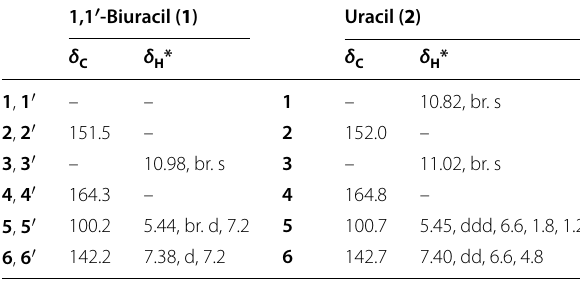
, δ ; 150 MHz, DMSO- d 6 H